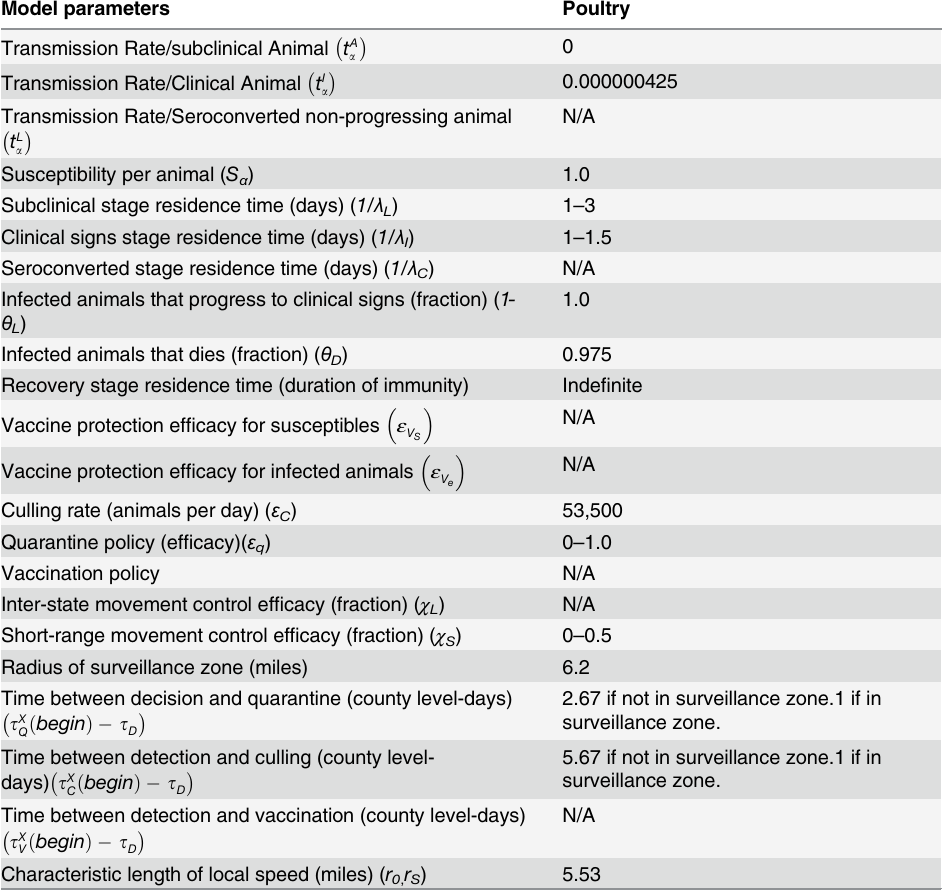
Table 1. Biological and control measure model parameters used for highly pathogenic H5N1 in Nigeria. Model